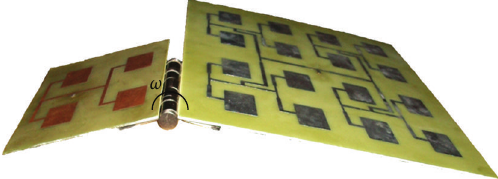
Figure 10: The investigated